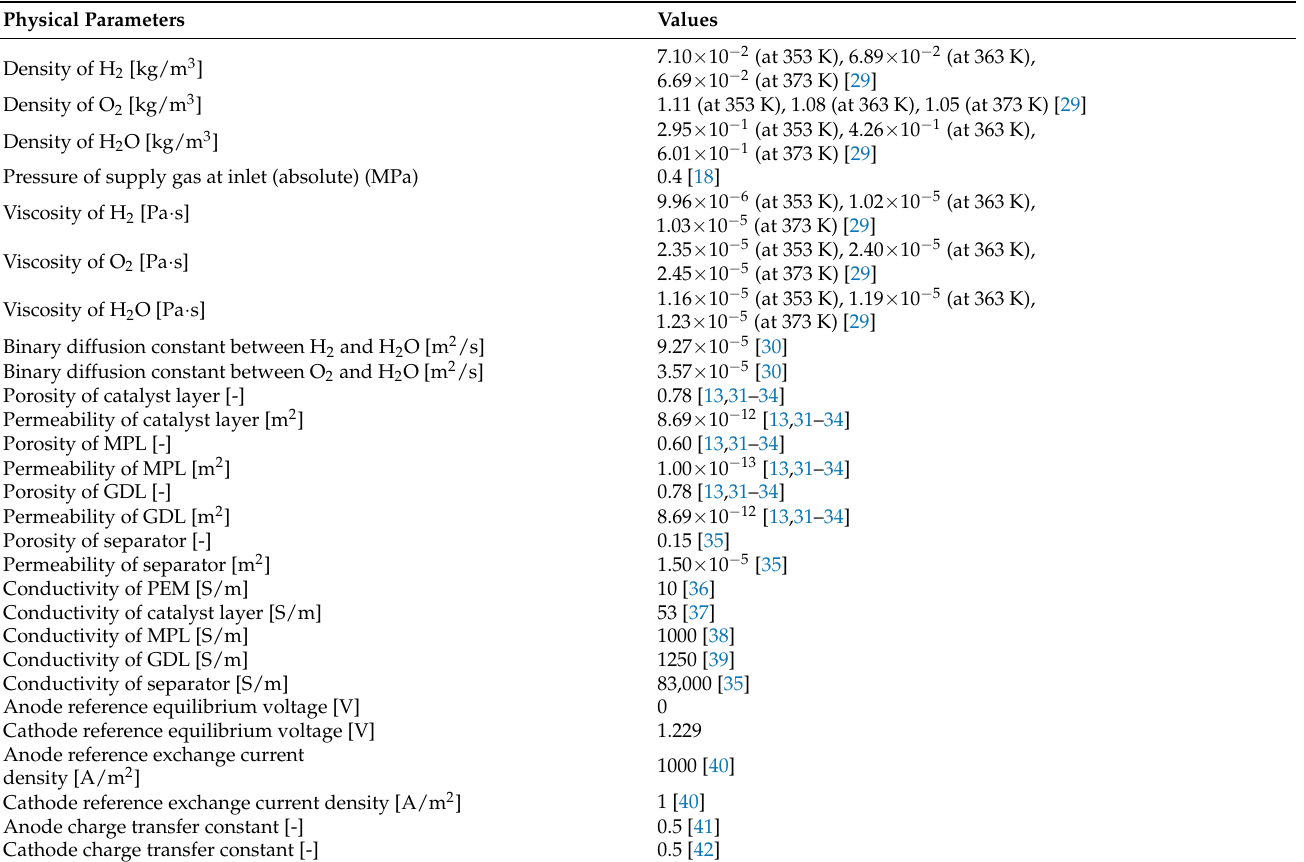
Table 2. Physical parameters for gases, components and electrochemical reactions set in the numerical simulation in this